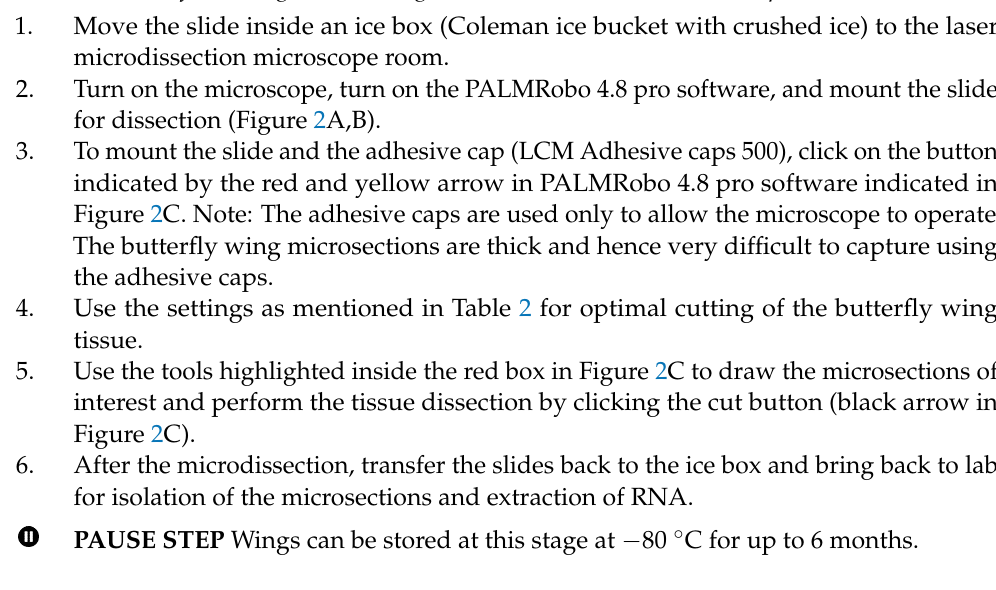
Table 2. Settings for the PALMRobo 4.8 pro software for the dissection of butterfly larval and pupal wing tissues. wing